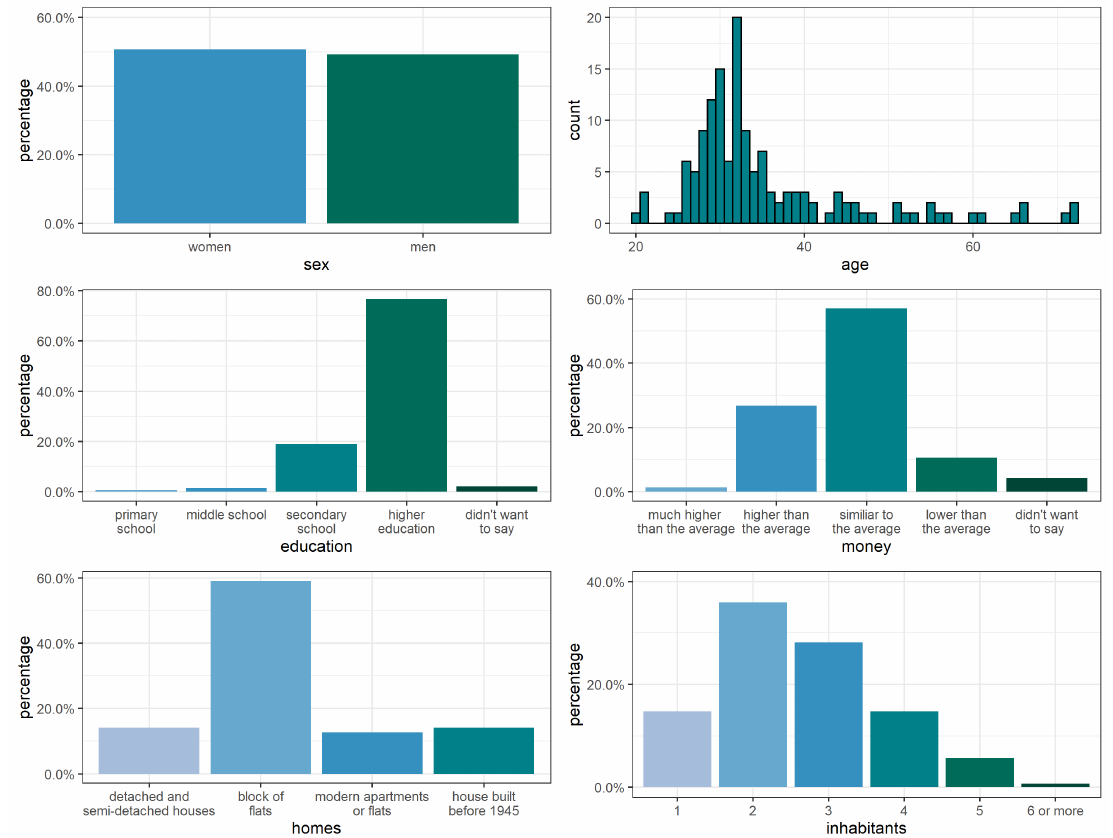
Figure 2. Frequencies of the demographics for participants who completed all measurement points of the study ( n = 142).